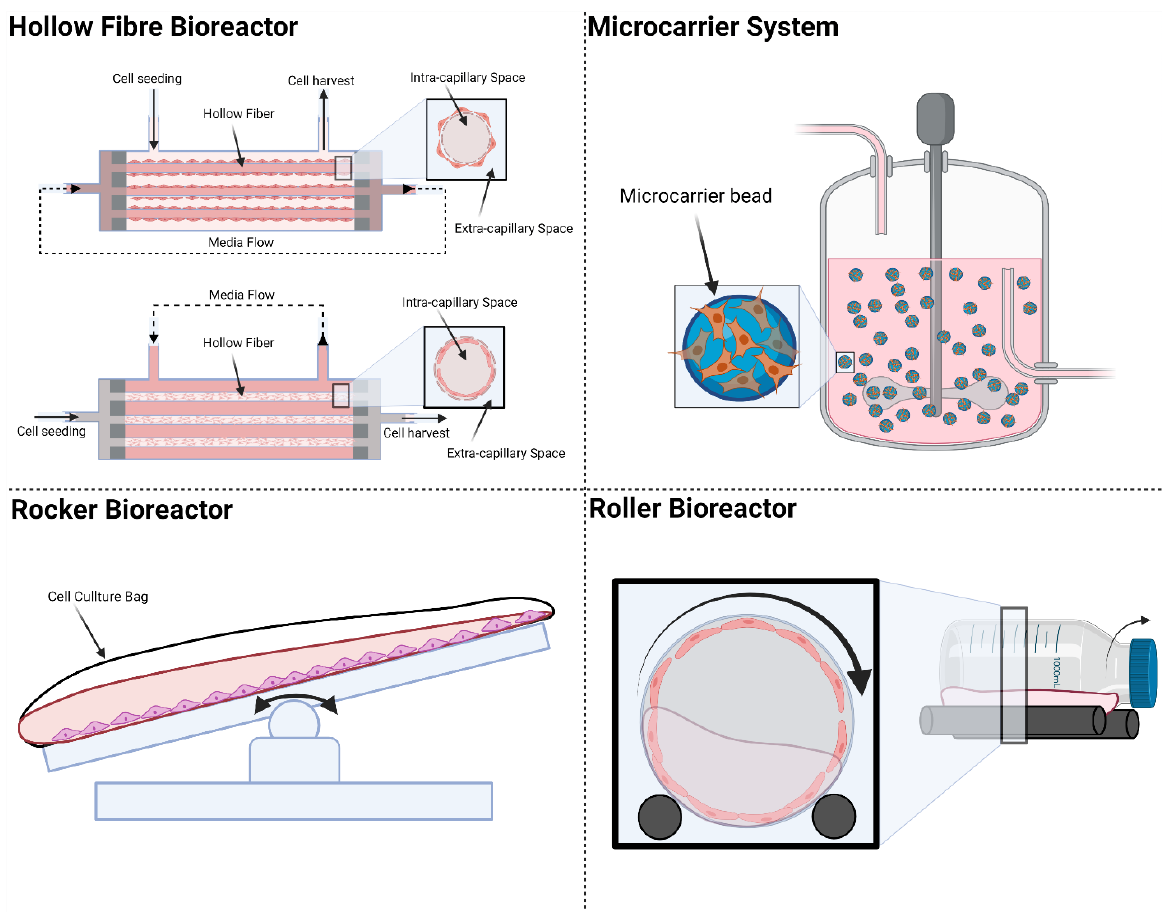
Figure 2. Existing cell culture platforms: Hollow Fibre bioreactors, microcarriers, rocker bioreactors, and roller bioreactors. Created with BioRender.com on 1 October 2021.